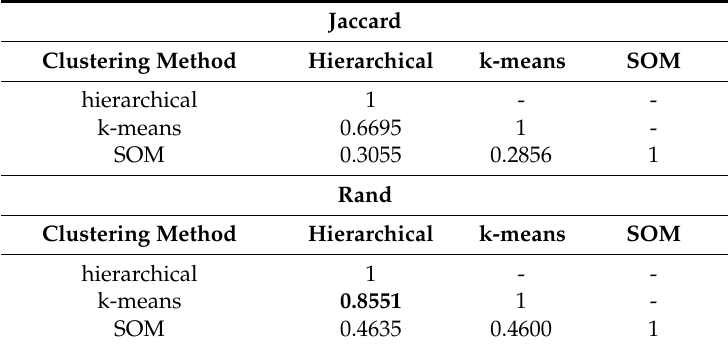
Table 5. Similarity assessment using Jaccard’s and Rand’s